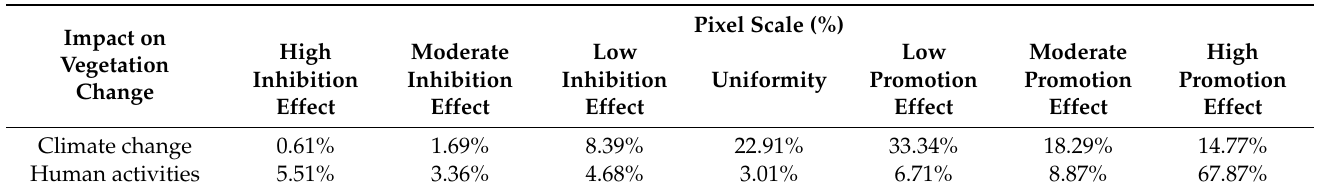
Table 6. Statistics on the influence of climate change and human activities on vegetation cover change in the Yangtze River Basin from 2000 to